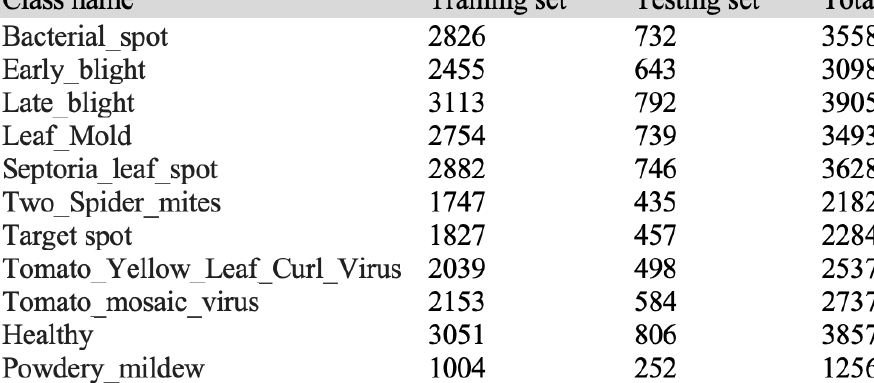
Figure 4. Dataset description.